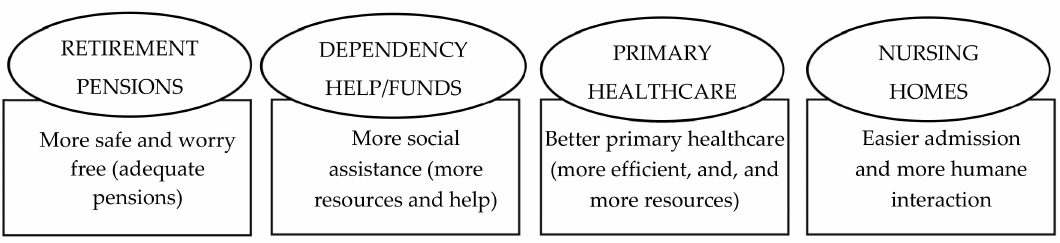
Figure 6. Needs not covered by the health and social public services, according to the